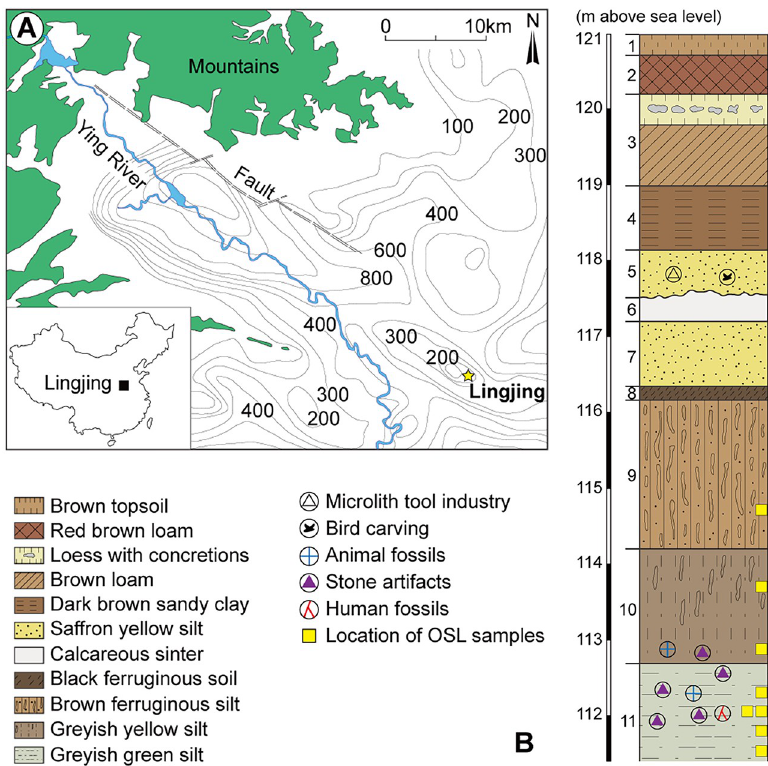
Fig 1. Location of the Lingjing site, and schematic representation of the stratigraphy. Reprinted from [31] under a CC BY license, original copyright 2018.